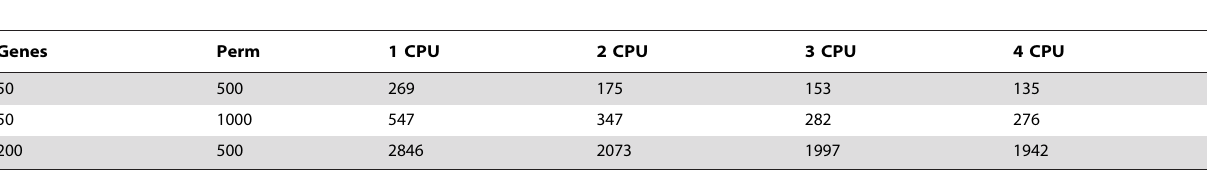
Table 3. Timings for 4 different execution of LABNet running in sequential (1 CPU) and parallel environments from 2 to 4 CPUs on general purpose hardware (1.3 GHz Intel Core i5), 4GB